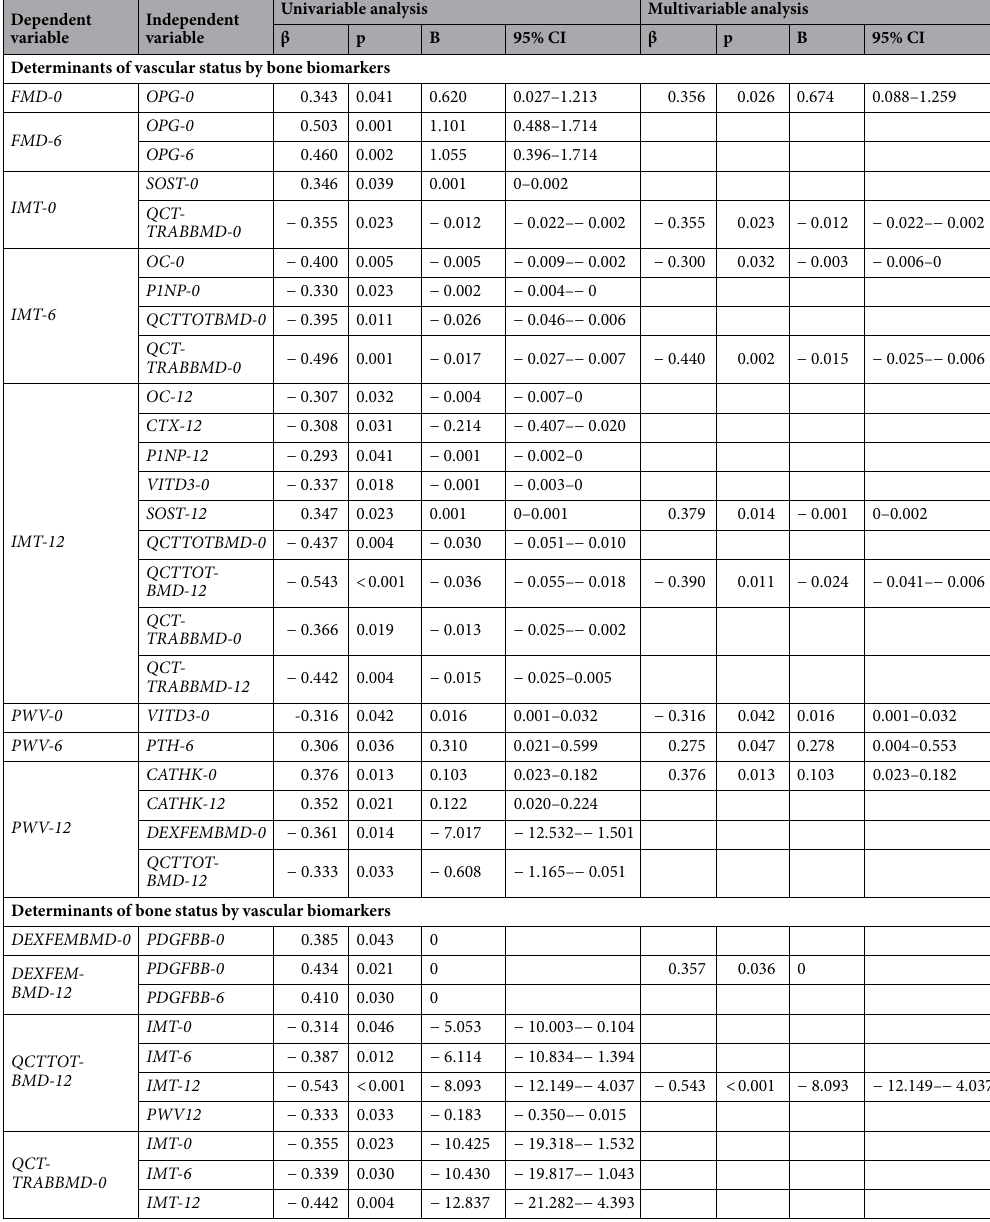
Table 3. Univariable and multivariable analysis of determinants of vascular and bone status. BMD bone mineral density, CATHK cathepsin K, CTX C-terminal telopeptide, DEXFEMBMD DXA femoral neck